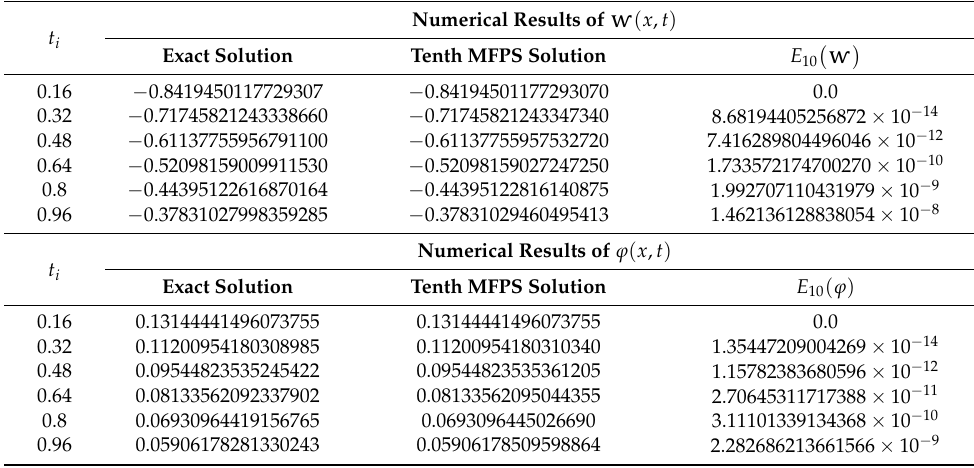
Table 2. Numerical results for Example 2 at α = 1, and n = 10.